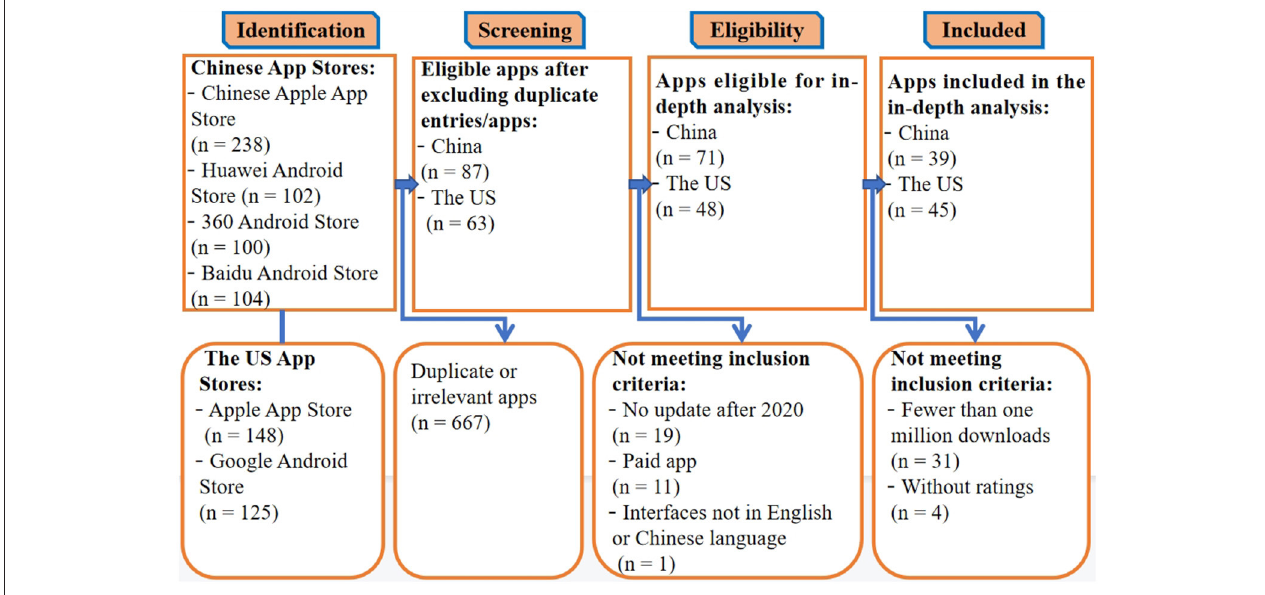
FIGURE 1 | Flowchart of the app selection